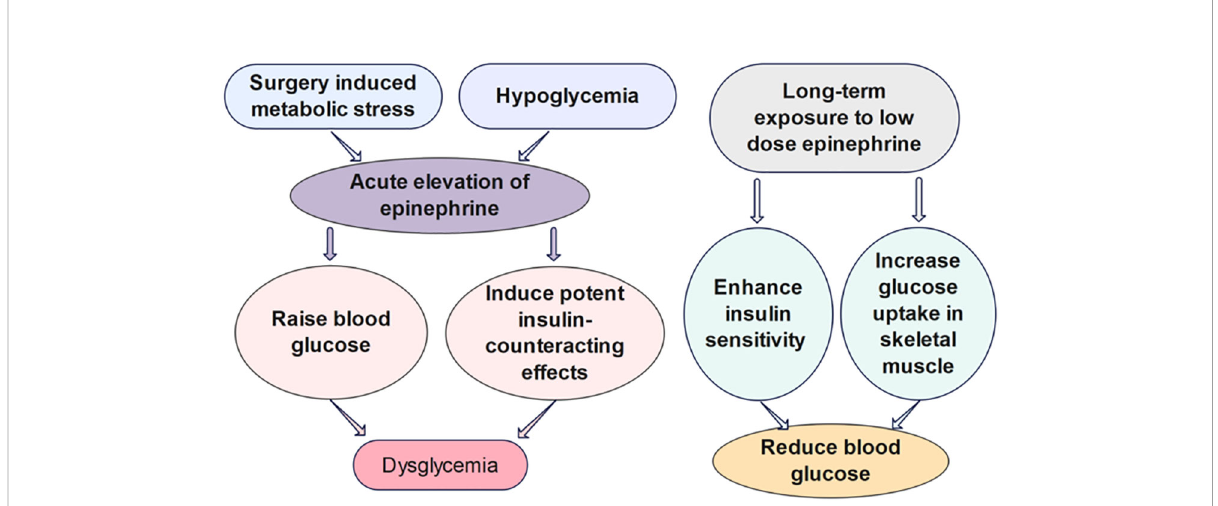
FIGURE 2 The effects of epinephrine on glucose regulation. Surgery induced metabolic stress, which causes the acute elevation of epinephrine, can signi fi cantly increase the rate of dysglycemia of hospitalized patients. The acute in fl uence of epinephrine on the glucose regulation have been shown to be divergent from the impact of chronic infusion of low-dose epinephrine in vivo (30 –